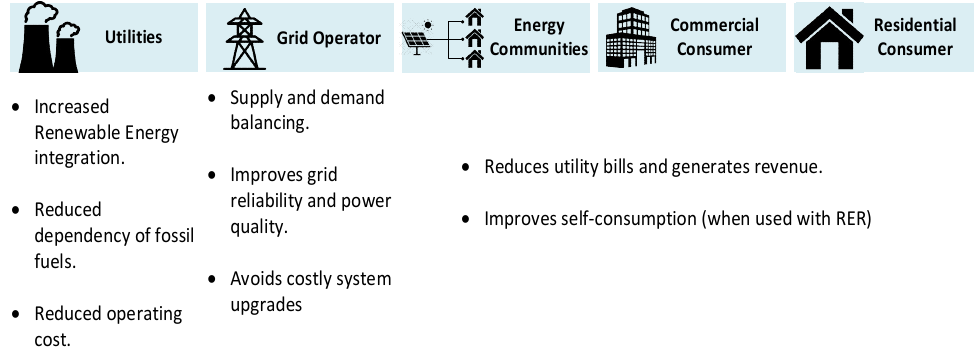
Figure 4. Objectives of energy flexibility for key stakeholders in the electric grid [40].